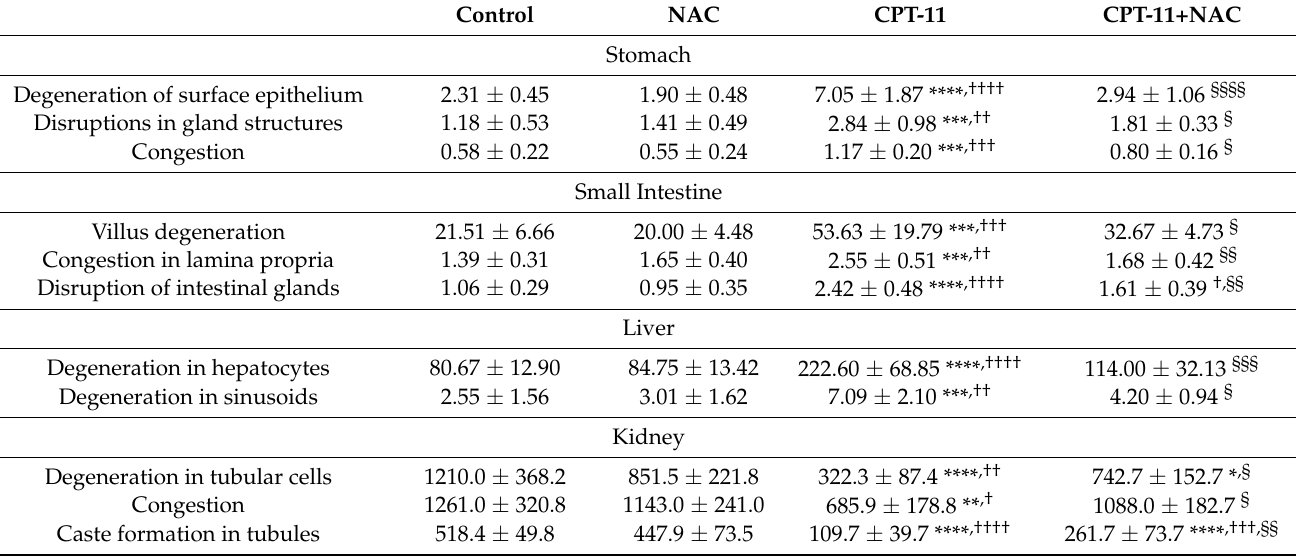
Table 3. Scores of tissue homogenate (stomach, small intestine, liver, kidney) histomorphological measurements (Mean ±